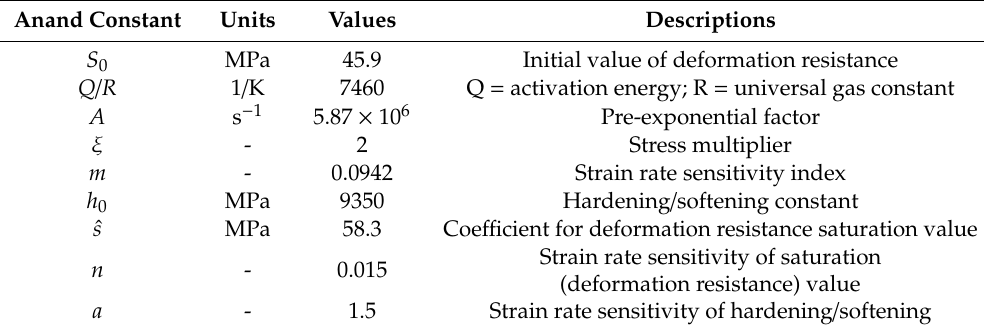
Table 1. The Anand model parameter setting for SAC305 solder